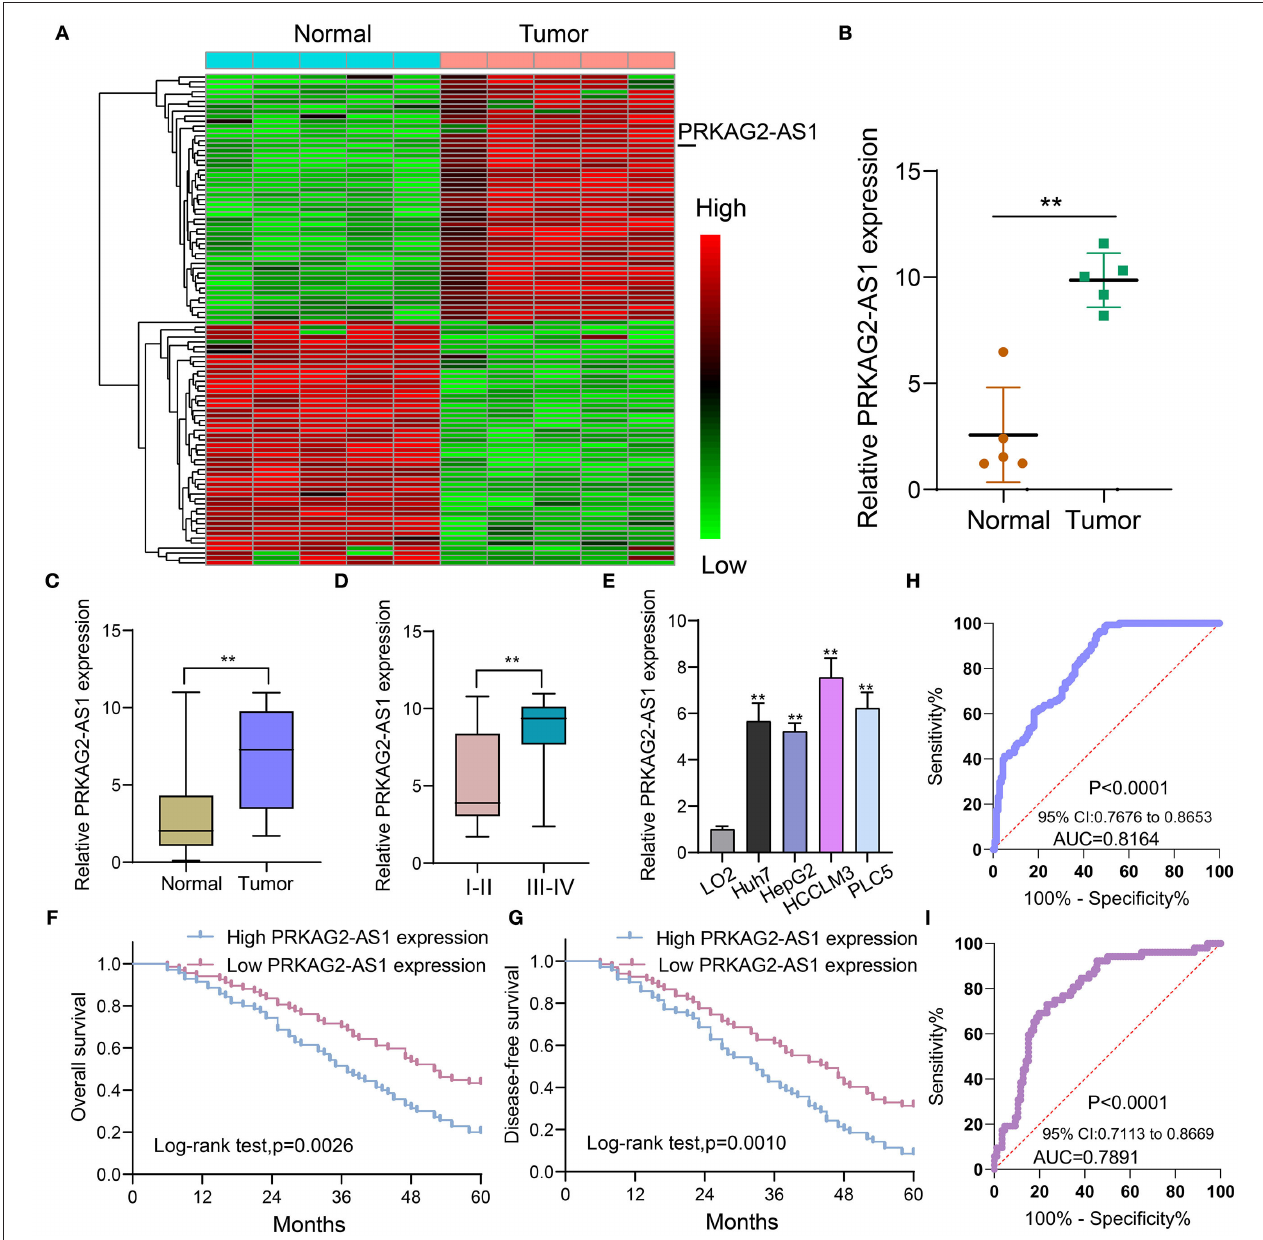
FIGURE 1 | Antisense lncRNA PRKAG2-AS1 is up-regulated both in HCC tissues and cells and could predict clinical outcomes of patients. (A) Heat map for dysregulated expressed lncRNAs between HCC and normal tissue specimens from the GEO database. Red: up-regulation and green: down-regulation. (B) According to microarray results, PRKAG2-AS1 expression was visualized between HCC and normal tissue specimens. (C) RT-qPCR confirming the up-regulation of PRKAG2-AS1 in HCC than normal tissue specimens in an HCC cohort ( n = 138). (D) Violin diagram for the differences in PRKAG2-AS1 expression between stage I-II and III-IV HCC patients. (E) RT-qPCR examining PRKAG2-AS1 expression in normal liver cells (LO2) and four kinds of HCC cells (Huh7, HepG2, HCCLM3, and PLC5). (F,G) Kaplan-Meier curves for OS and DFS among HCC patients, assessed by log-rank test. (H,I) ROCs for OS and DFS based on PRKAG2-AS1 expression. ** p <